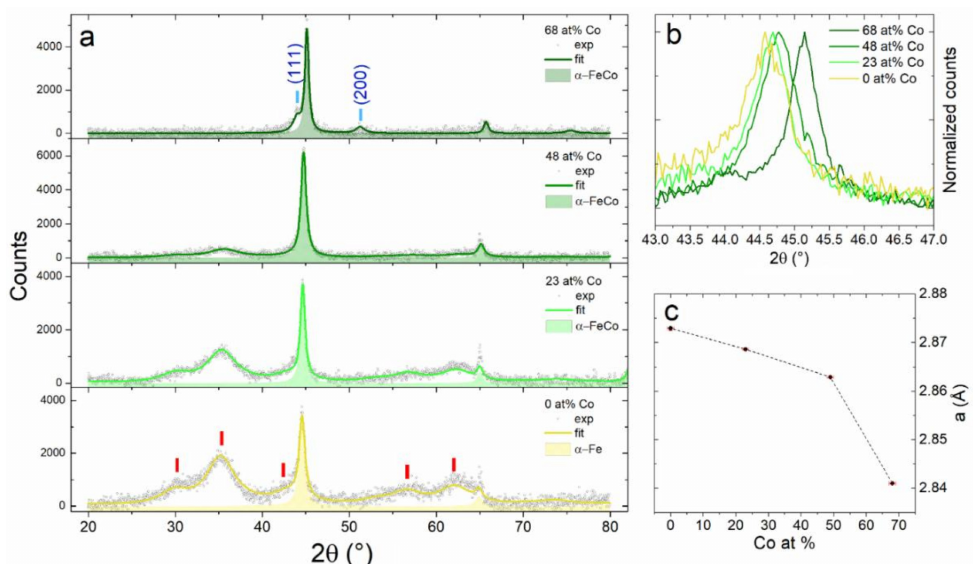
Figure 5. ( a ) XRD patterns of Fe 100-x Co x samples (x = 68-0 from top to bottom). Grey circles represent experimental data, while the colored solid lines are the best fits. The colored area highlights BCC peaks of the alloy, while colored vertical bars marks the Bragg reflections of cobalt ferrite (red) and FCC Fe-Co alloy (cyan); ( b ) A detail of the experimental data showing the shift of the (110) BCC reflection with increasing Co content; ( c ) Lattice parameter a obtained from Rietveld refinement (Table 5) as a function of Co content, with the error bars are displayed in